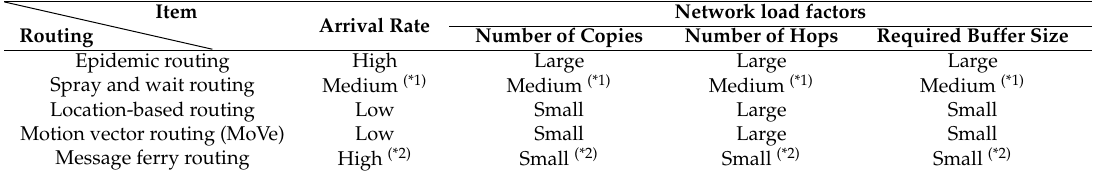
Table 2. Comparison of the existing routing methods in terms of network characteristics.